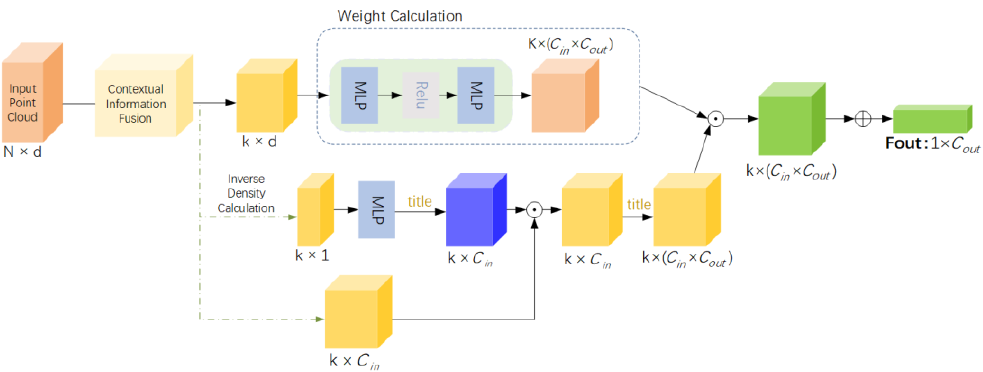
Figure 3. The schemes of density-based point